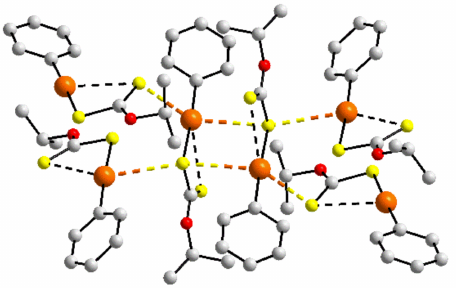
Figure 11. Supramolecular association in a zero-dimensional aggregate featuring six Hg ··· S interac- tions: 37